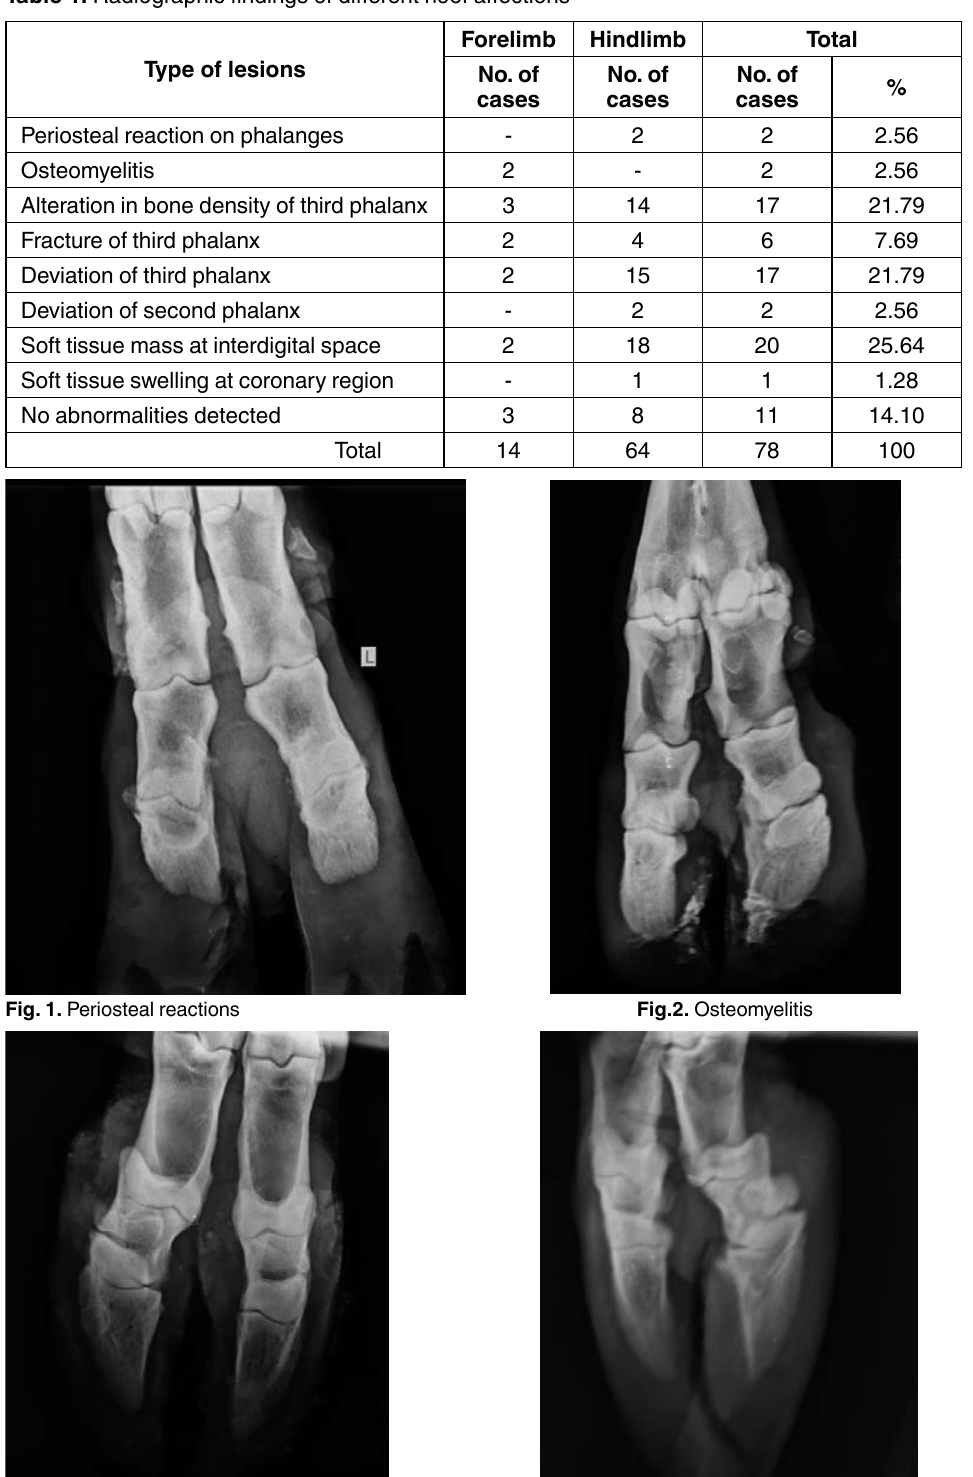
table 1. Radiographic findings of different hoof affections